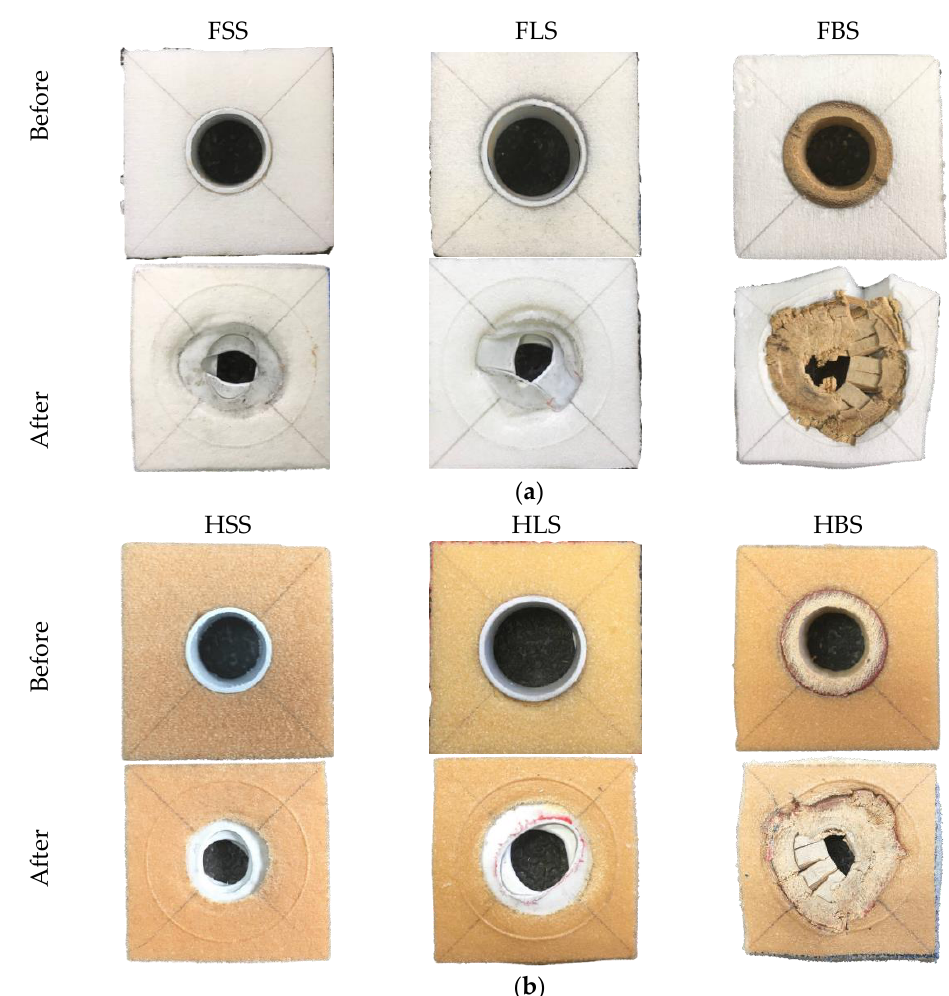
Figure 9. The top view of single tube reinforced with ( a ) F50, and ( b ) HP80 foam structures.